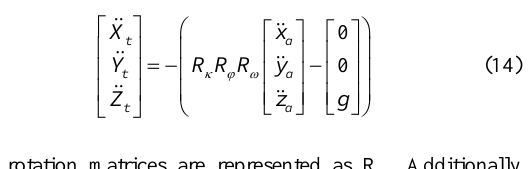
Figure 2. Flow of the POS and camera integration